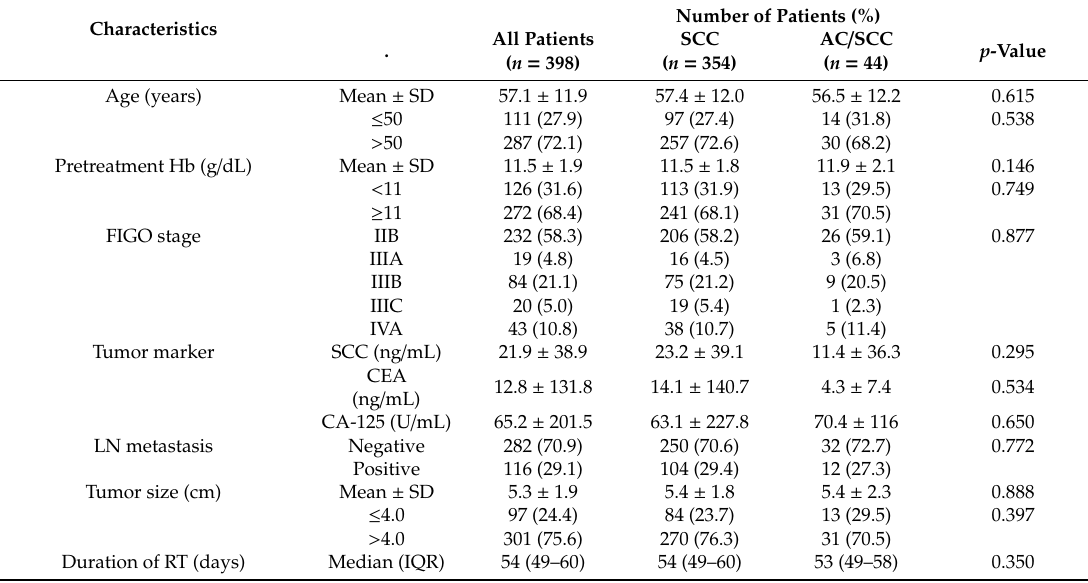
FIGO, International Federation of Gynecology and Obstetrics; SD, standard deviation; IQR, interquartile range; RT, radiation therapy.